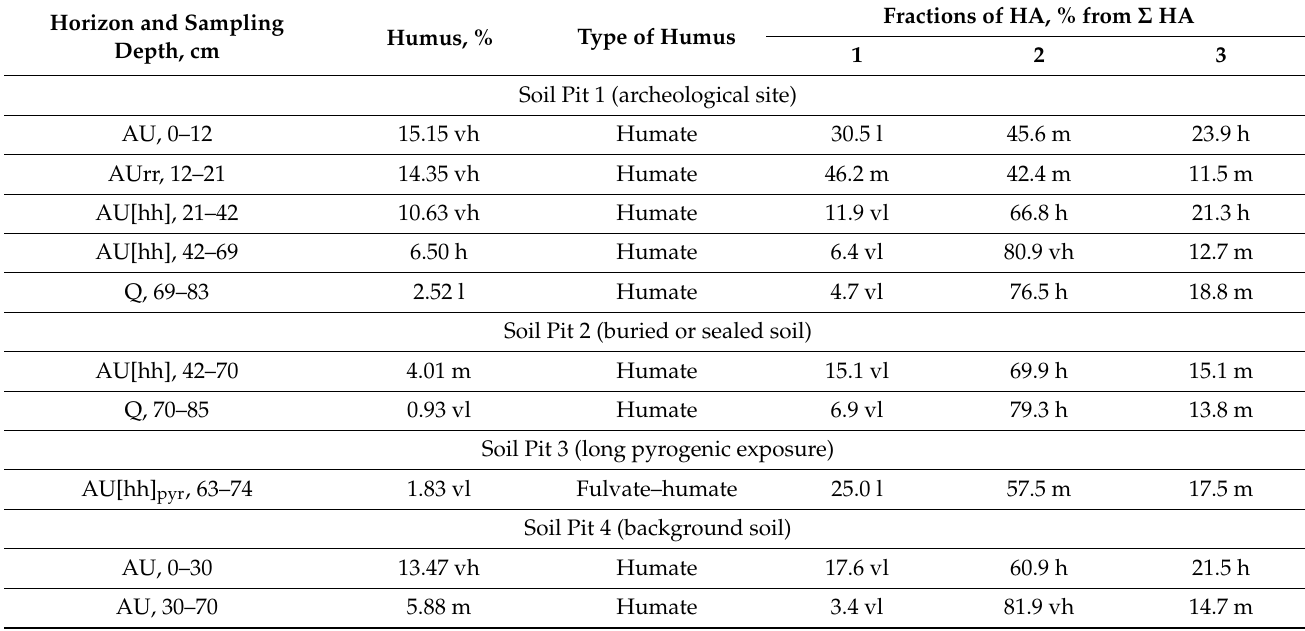
Table 3. Humus content, its type, and distribution HA